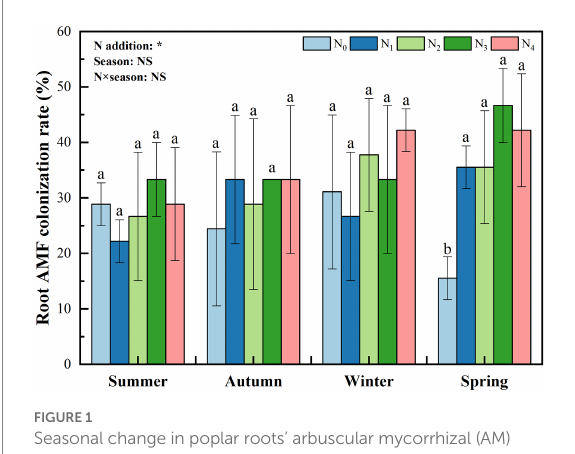
FIGURE 1 Seasonal change in poplar roots’ arbuscular mycorrhizal (AM) fungal colonization rate with different nitrogen additions. N 0 , N 1 , N 2 , N 3 , and N 4 were 0, 5, 10, 15, and 30 gN·m − 2 ·a − 1 , respectively. The values are the means of three replicates ± SD. Different lowercase letters within the same season indicate significant differences among nitrogen additions at the 0.05 level. Two-way ANOVA outputs are shown in the figure. NS, not significant; *, p <